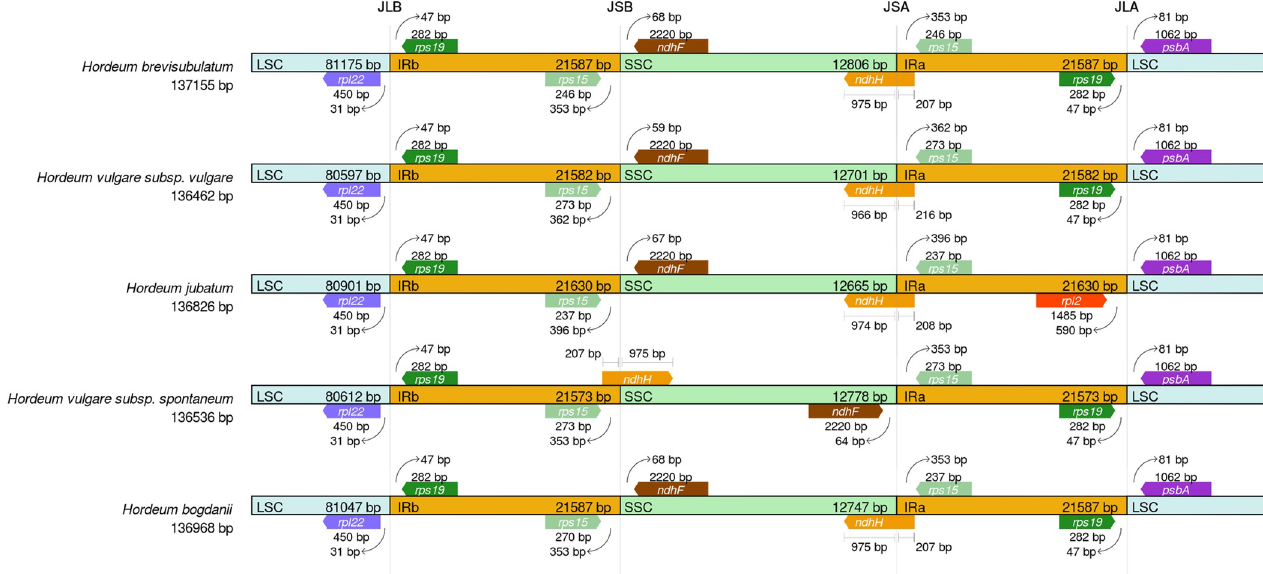
Fig 6. Comparison of the large single copy (LSC), small single copy (SSC), and inverted repeat (IR) regions in cp genomes of five Hordeum species. Genes and regions are denoted by colored boxes. The gaps between the genes and the boundaries are indicated by the base lengths (bp). Extensions of the genes are indicated above the boxes. The lengths of the four regions are also shown in the